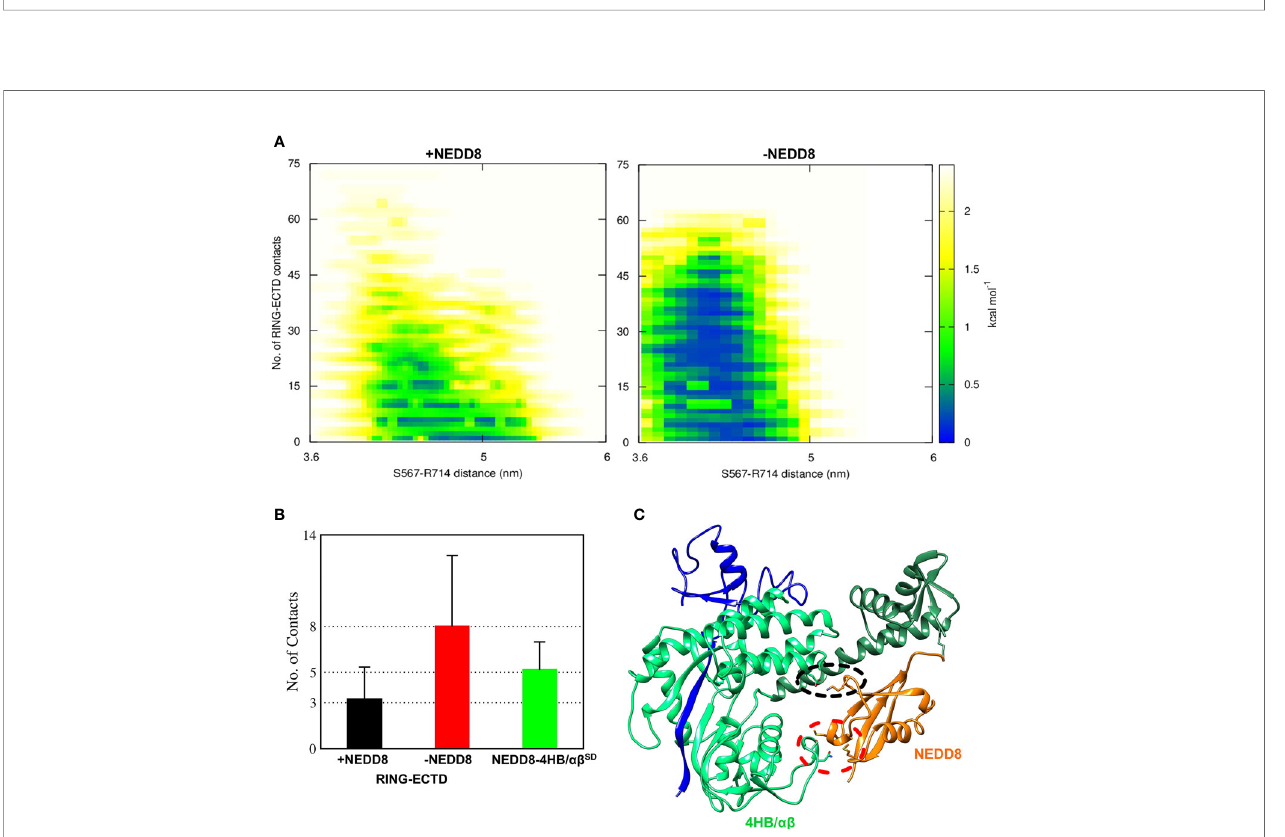
FIGURE 4 | NEDDylation biases the conformational landscape of Cullin CTD -Rbx1 towards an ensemble of open conformations which minimize RING/ECTD interaction. (A) 2D-free energy landscapes calculated for the open state of Cul5 CTD -Rbx1 with and without NEDD8 from 1.6 m s macro trajectories obtained by combining eight independent 200 ns trajectories for each state. Upon removal of NEDD8, ECTD/RING interaction is more favorable. (B) Mean + SEM for several ECTD/Rbx1 RING and 4HB/ ab SD -NEDD8 contacts across all Cul5 CTD -Rbx1 trajectories initiated from the open state with and without NEDD8. Contact cutoff was chosen to be 0.4 nm. (C) A representative conformation of NEDD8~Cul5 CTD -Rbx1 showing NEDD8 interacting with 4HB/ ab SD . Interacting atoms are shown as sticks. A black dotted circle indicates a salt bridge between NEDD8 (K48) and 4HB SD (E407). The red dotted circle indicates van der Waals interactions between NEDD8 (M1/M62) and ab SD